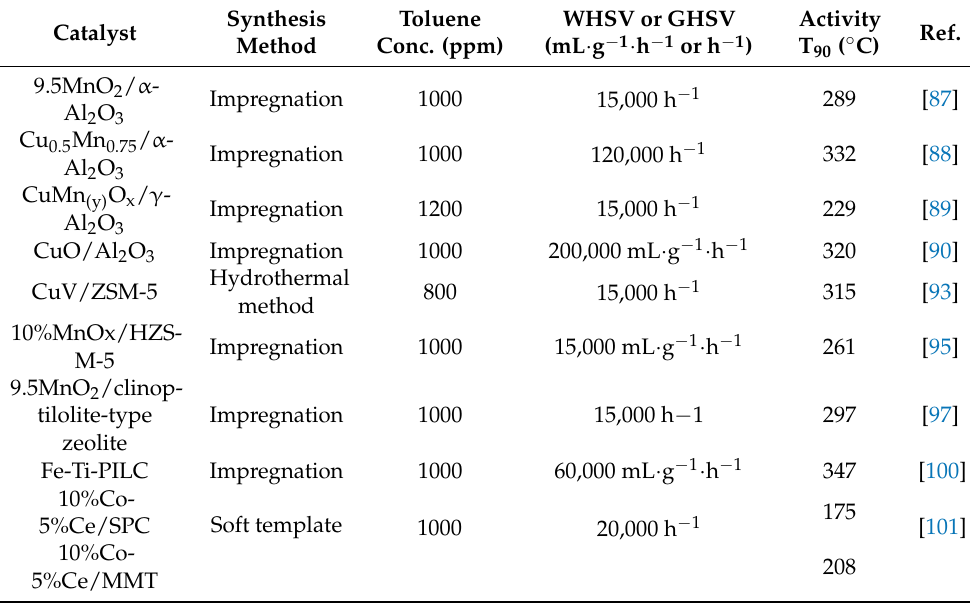
Table 3. Catalytic activity for toluene combustion over supported metal oxide catalysts reported in the recent